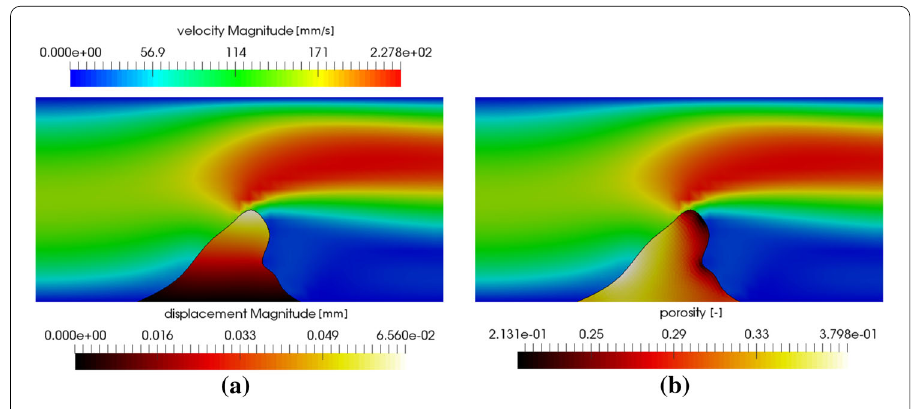
Fig. 14 Solution of the reference simulation for the porous example. Fluid velocity magnitude and a skeleton displacement and b porosity